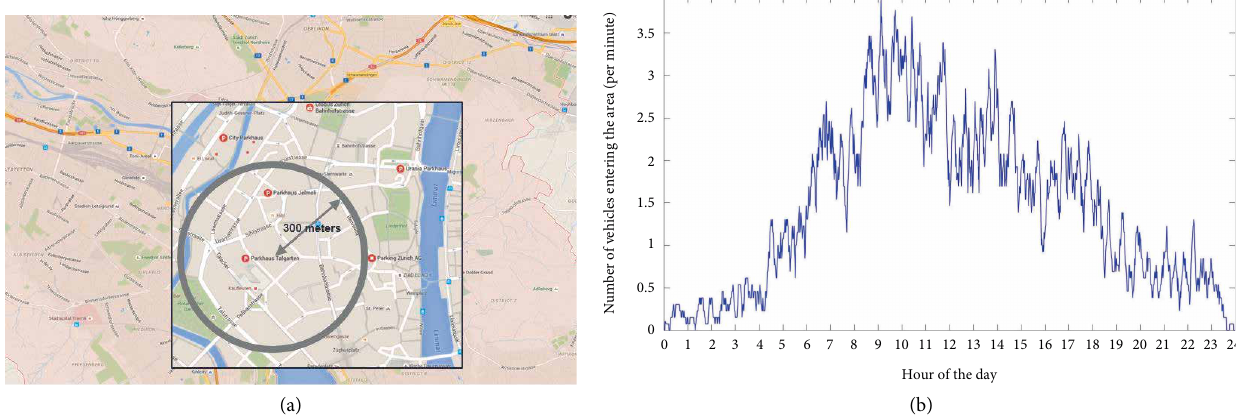
Figure 4: Case study area and parking demand per minute computed as a moving average over the city center of Zurich. (b) Number of vehicles entering the area over one day.